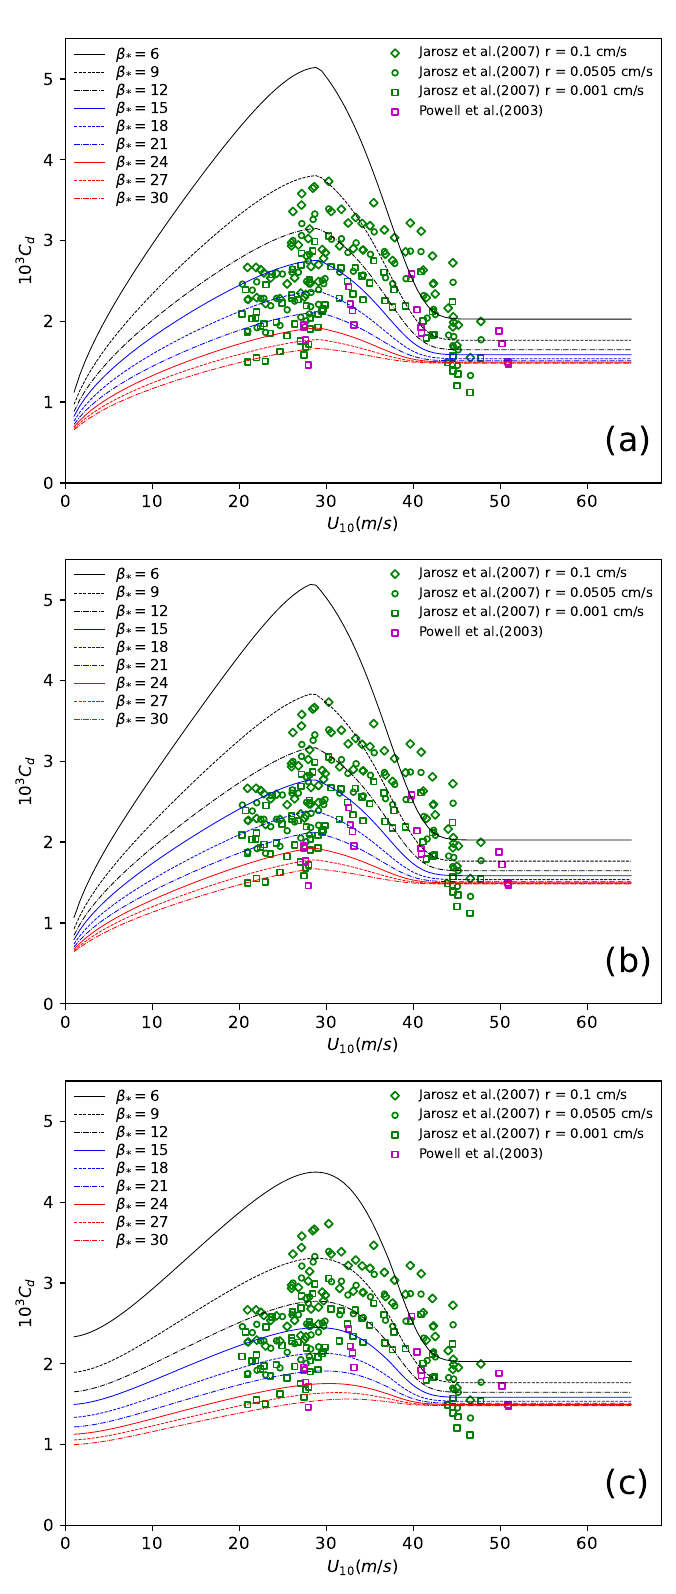
Figure 8. Comparison between C d predicted by the new parameterization with the effect of sea foam (Equation (29)) under different wave ages using H s estimated from ( a ) Taylor and Yelland [51]; ( b ) Fairall et al. [81]; and ( c ) Wang et al. [82] and the field